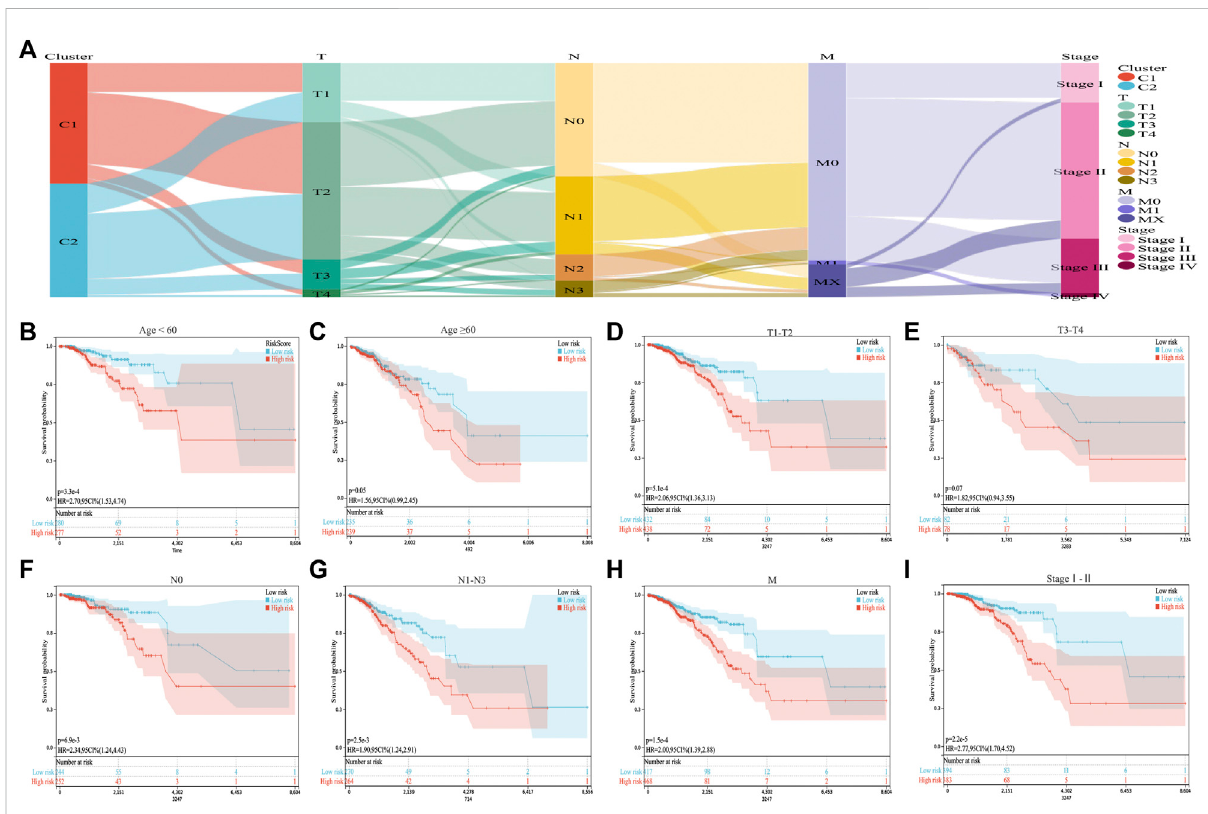
FIGURE 6 CorrelationbetweentheICDriskmodelandclinicalprognosis. (A) SankeydiagramshowingthedistributionofBCclinicalinformationinthetwo subtypes. (B – I) Survival prognosis diagram, which analyzes the relationship with the ICD risk score with regards to age, tumor node metastasis classi fi cation, and clinical stage, which all show that a low ICD risk score indicates a better clinical